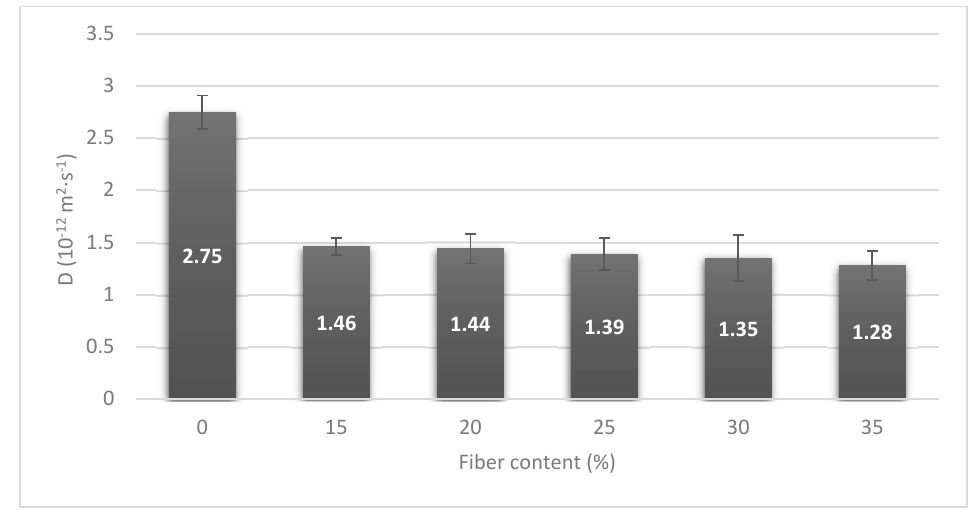
Figure 9. D parameter calculated in composite materials regarding fiber content.